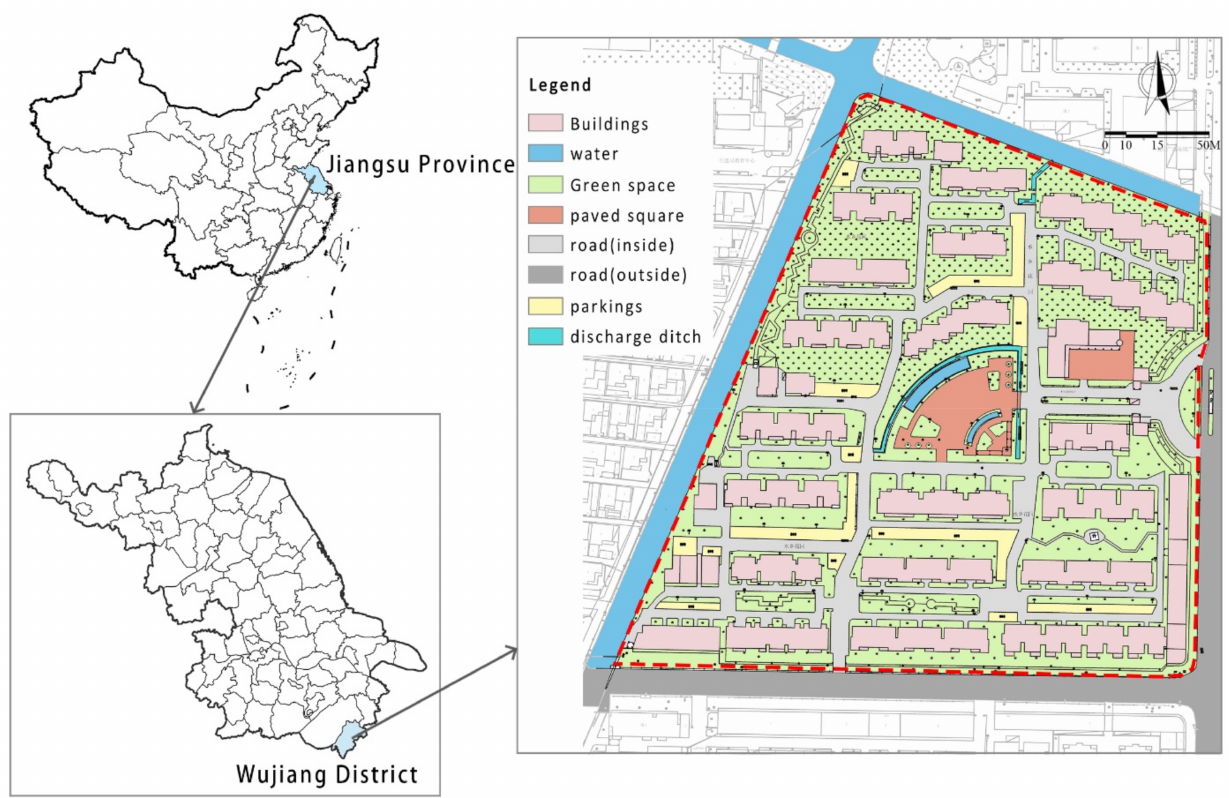
Figure 2. Location and land use map of the Shuixianghuayuan old residential area in the Songling Town, Wujiang District of Suzhou, China (31 ◦ 08 (cid:48) 59.6 (cid:48)(cid:48) N, 120 ◦ 38 (cid:48) 16.7 (cid:48)(cid:48) E), the Shuixianghuayuan old residential area in Wujiang District,